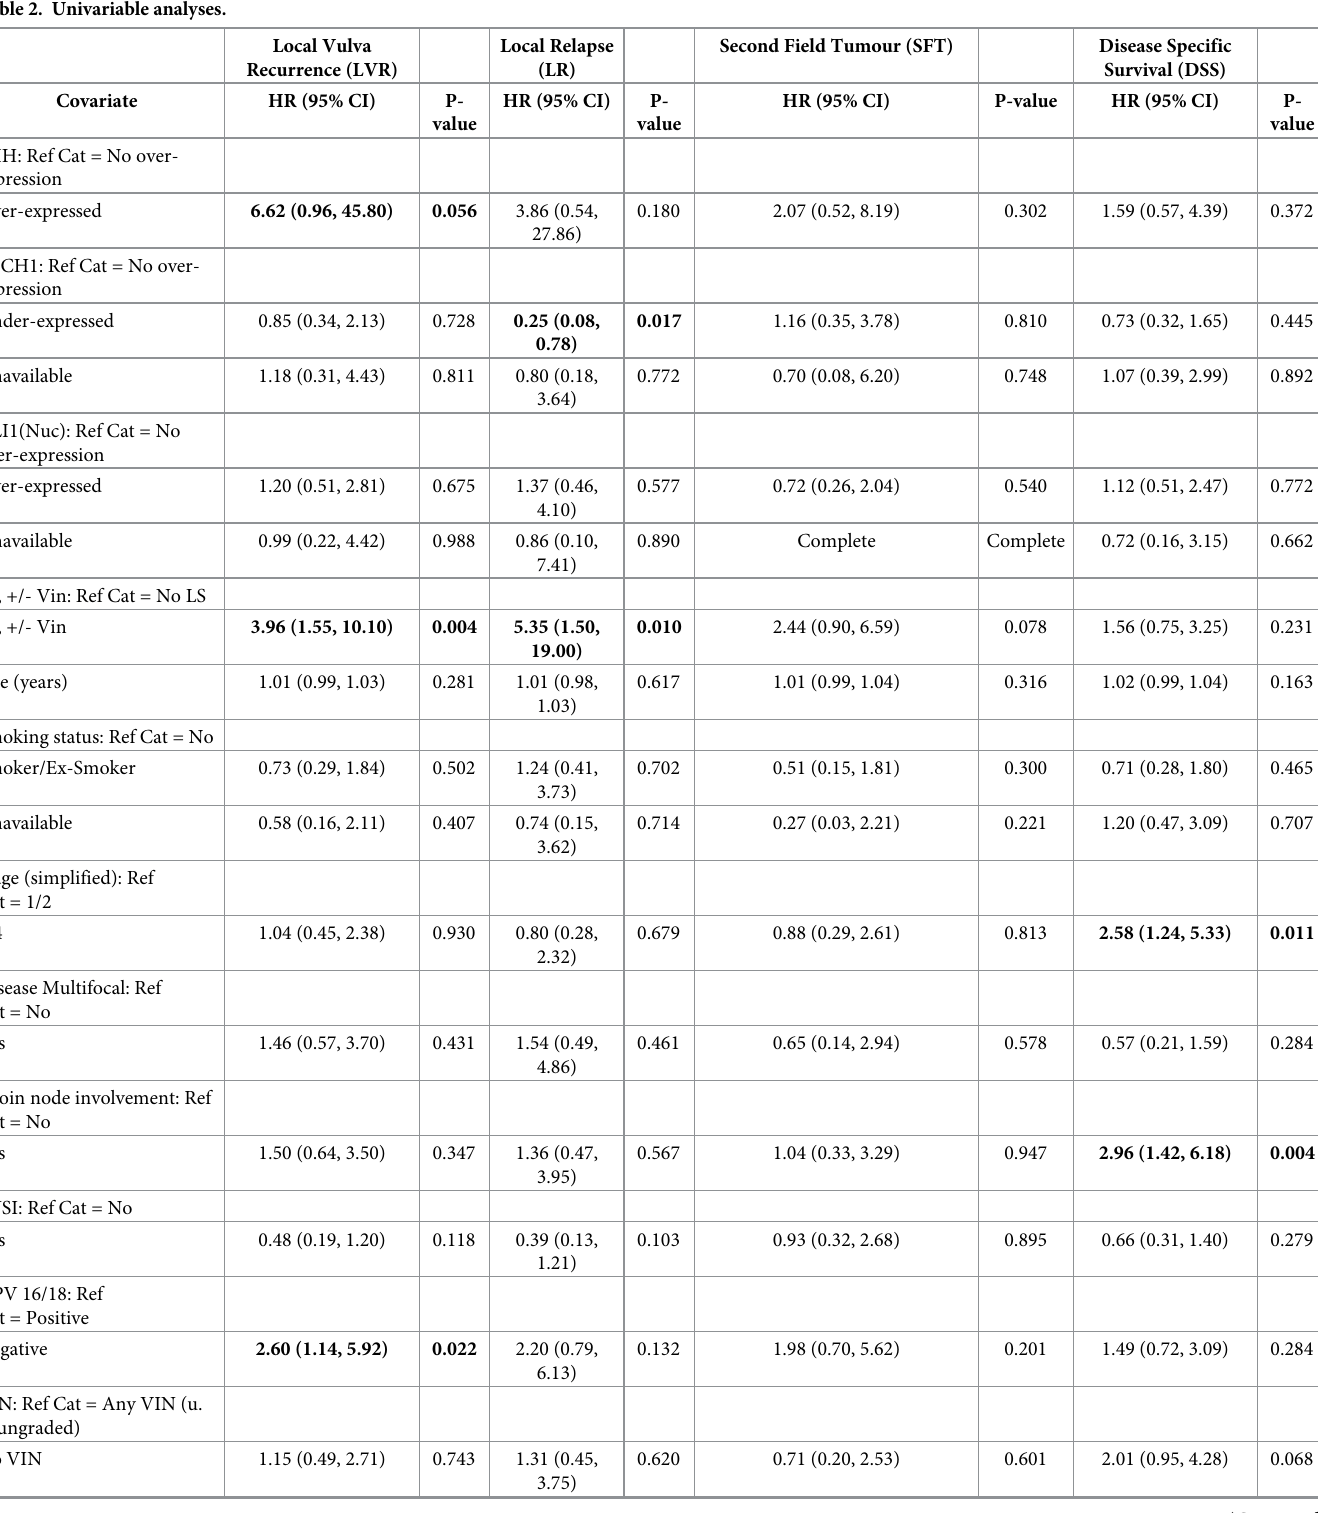
Table 2. Univariable